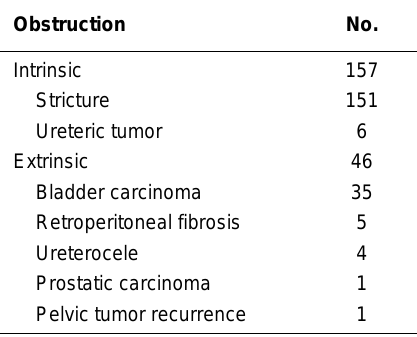
The Final Diagnosis of 203 Renal